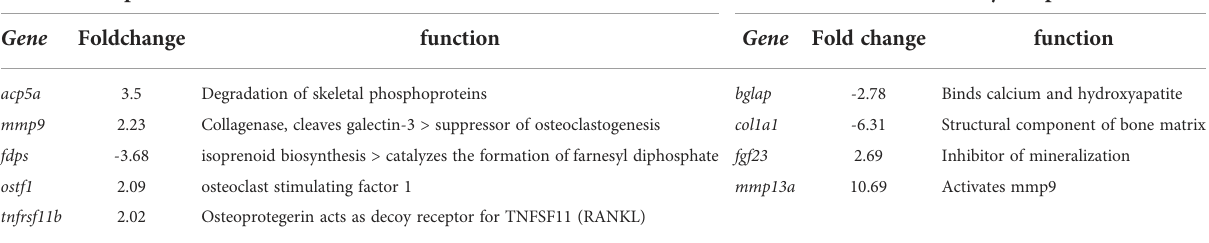
TABLE 1 Differentially expressed genes related to osteoblasts and osteoclast signaling. Osteoclast expressed Osteoblast/osteocyte expressed Gene Foldchange function Gene Fold